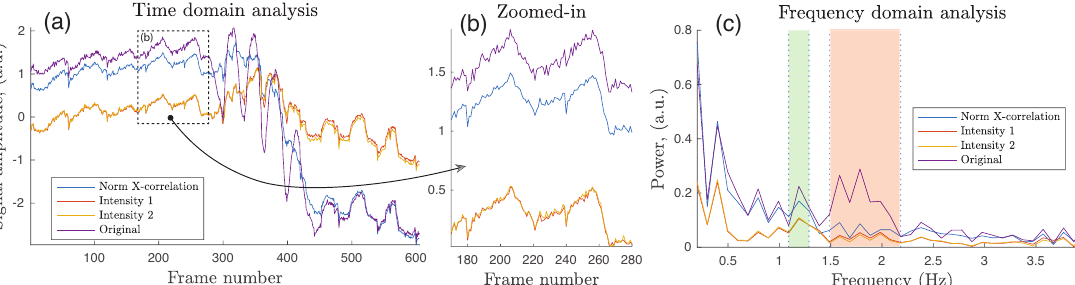
Figure 12. ( a ) Extracted iPPG signals with and without motion compensation applied. Signals were zero-centered by subtracting their temporal average. ( b ) Zoomed-in segment with vertical lines marking boundaries of cardiac cycles. ( c ) Frequency content of original and compensated iPPG signals. The green spectrum ( I ) is the expected cardiac-related region according to the reference contact probe cPPG, and the red spectrum ( II ) contains PPG harmonics and